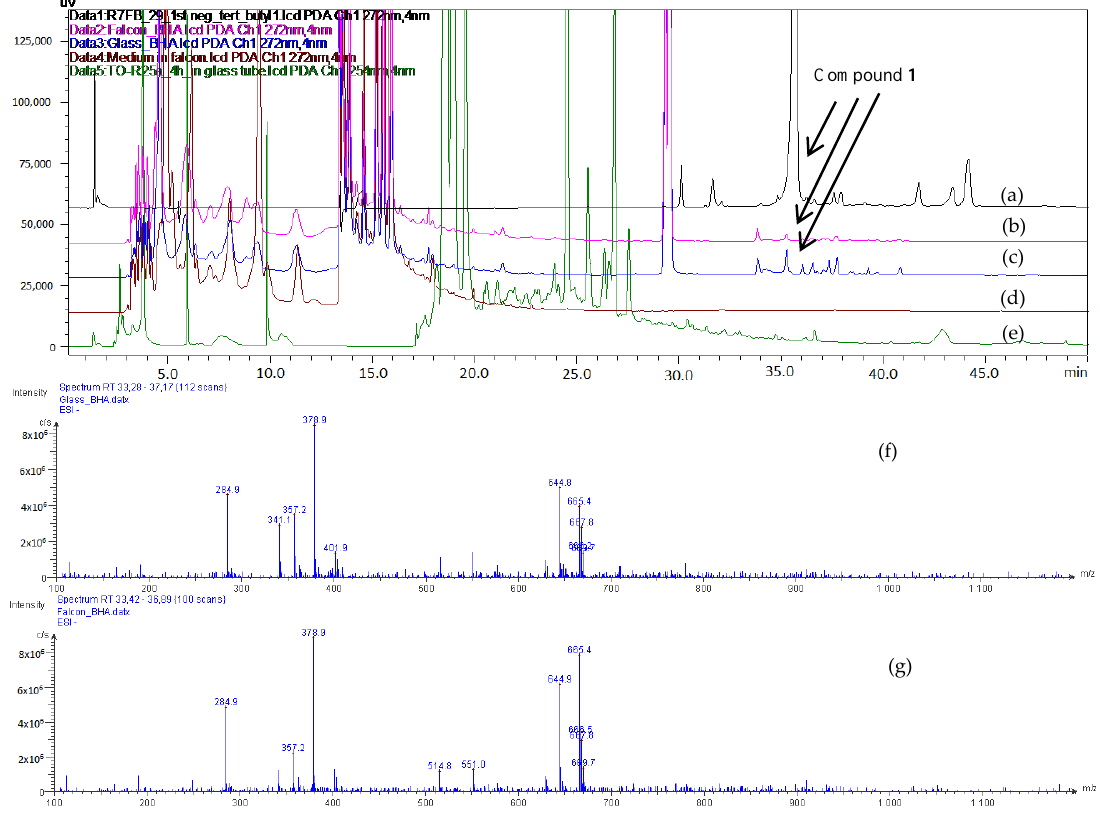
Figure 5. HPLC chromatograms of Compound 1 ( a ), of the extracts from P. odorifer culture supplemented with butylated hydroxyanisole (BHA) in the culture flask ( b ), or in the glass Erlenmeyer flask ( c ), of medium in the culture flask ( d ), and of the Paenibacillus odorifer ( P. odorifer ) culture in the Erlenmeyer flask ( e ). Electrospray ionisation (ESI)-MS ( − ) spectra of extracts from the P odorifer culture supplemented with BHA in the culture flask ( f ), or in the glass Erlenmeyer flask ( g ).